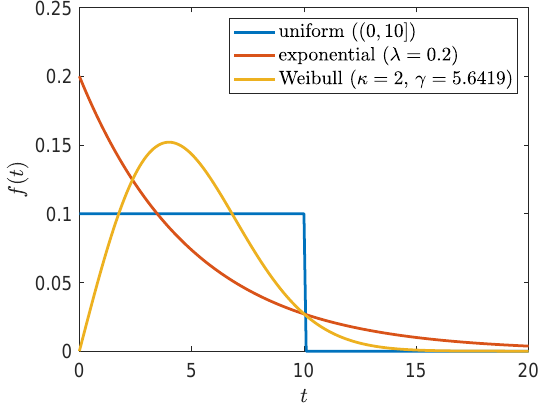
Figure 2: Holding-time distributions with mean 5.